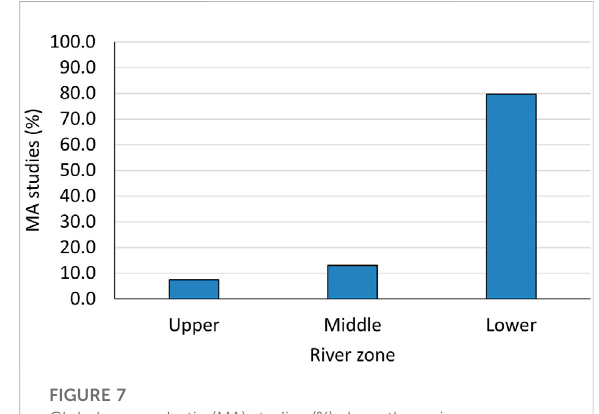
FIGURE 6 Frequency of studies (%) for macroplastics in rivers conducted on several matrices.